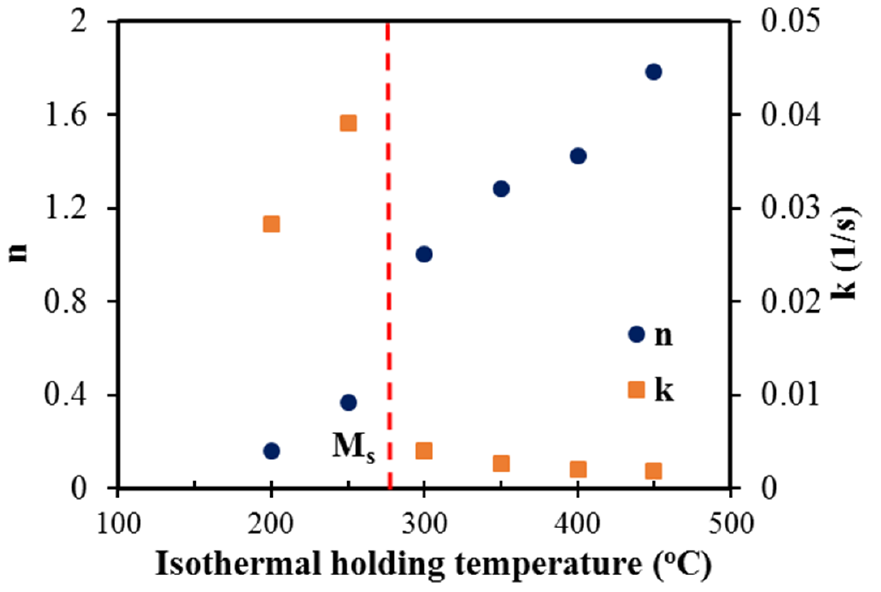
Figure 6. The variations of n and k with the isothermal holding temperature between 450 and 200 ◦